Question: Write a single sentence explaining what this figure depicts.
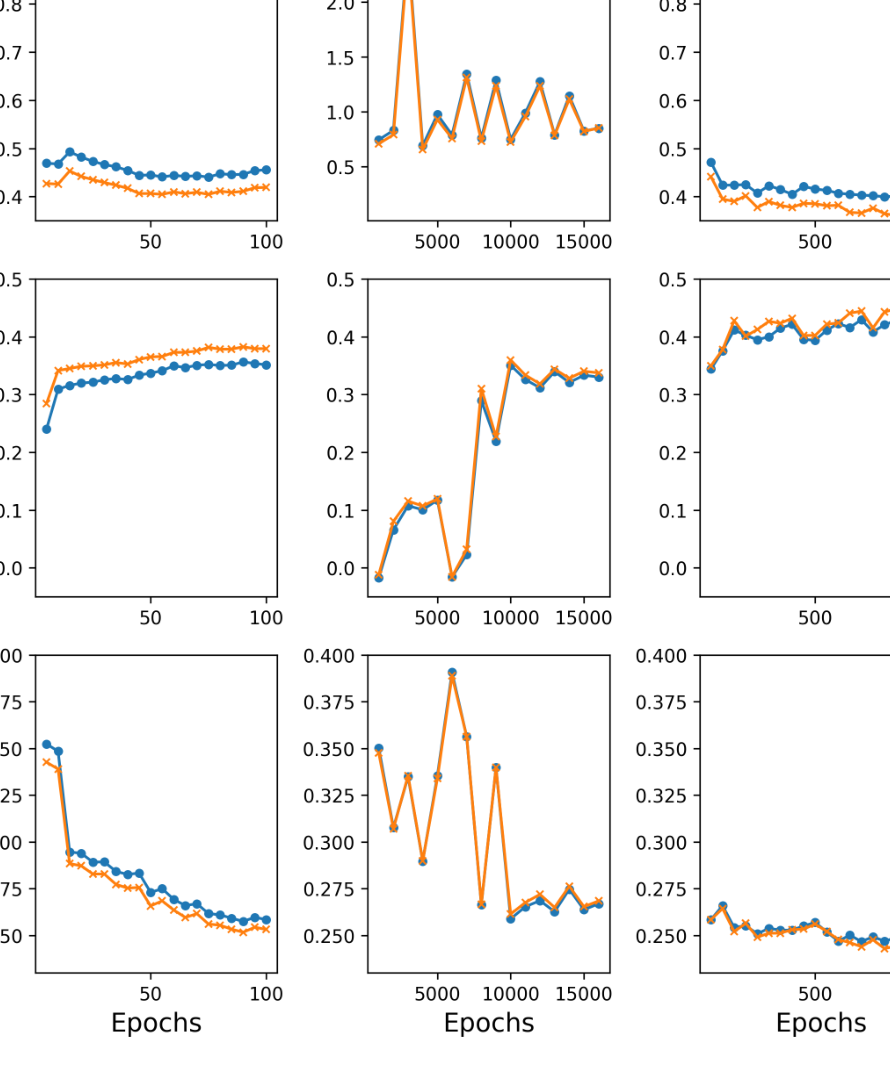
Answer: Line plots of evaluation metrics on training and test data across training epochs for various models.